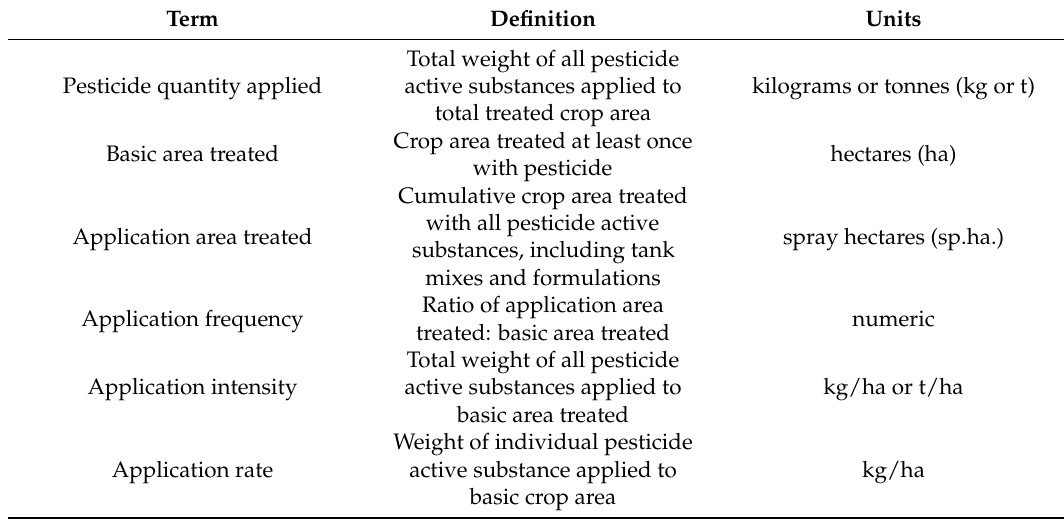
Table 2. Definition of terms used in the presentation of pesticide usage